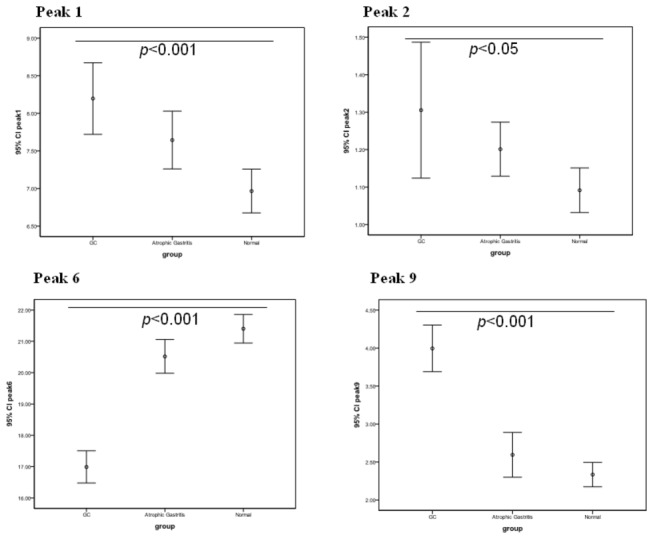
The changes in N-glycan levels for the 3 groups.In the gastric cancer (GC) group, the levels (represented as 95% confidence intervals [CIs]) of agalacto, core-α-1,6-fucosylated biantennary glycan (NGA2F,peak1), core-α-1,6-fucosylated bisecting biantennary glycans (NGA2FB, peak2) and branching α-1,3-fucosylated triantennaries (NA3FB, peak 9) were modestly elevated (P<0.05) and those of bigalacto core-α-1,6-fucosylated biantennary glycans (NA2F, peak 6) were decreased.